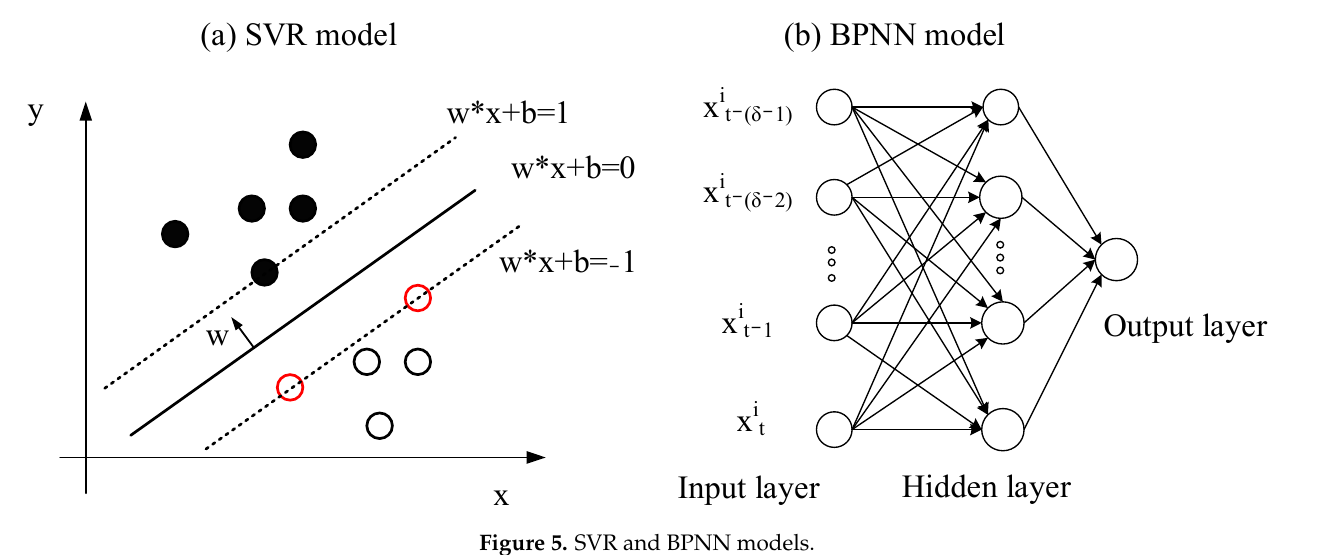
Figure 5. SVR and BPNN models.